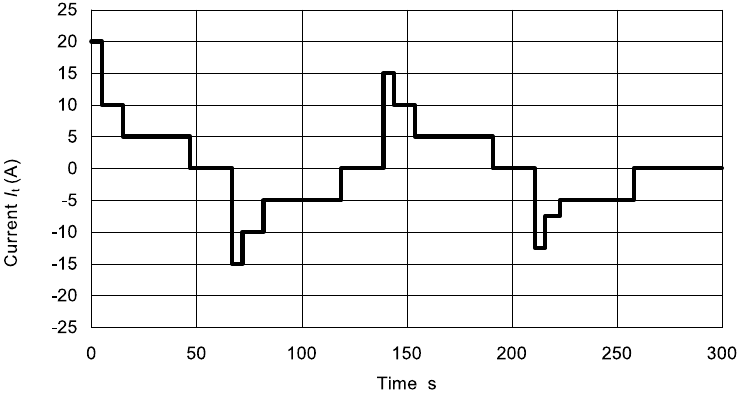
Figure 16. New life cycle method for high power applications [ 28 ]